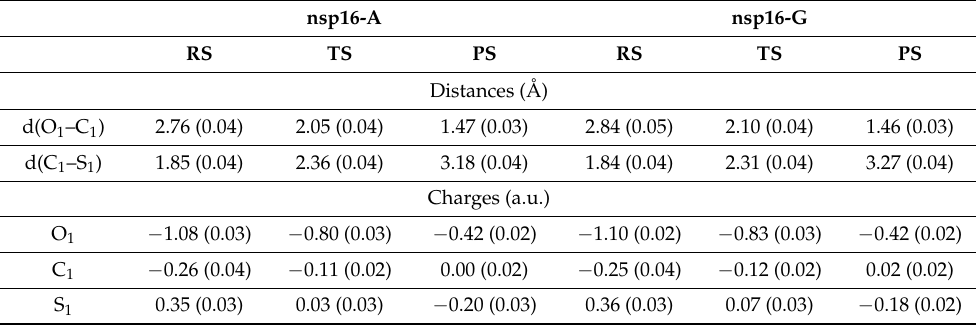
Table 2. Average key distances (Å) and partial charges (in atomic units) of key atoms involved during the S N 2 mechanism of the nsp16-A and nsp16-G systems obtained from DFTB3/MM umbrella sampling calculations. Standard deviations are shown in parenthesis.